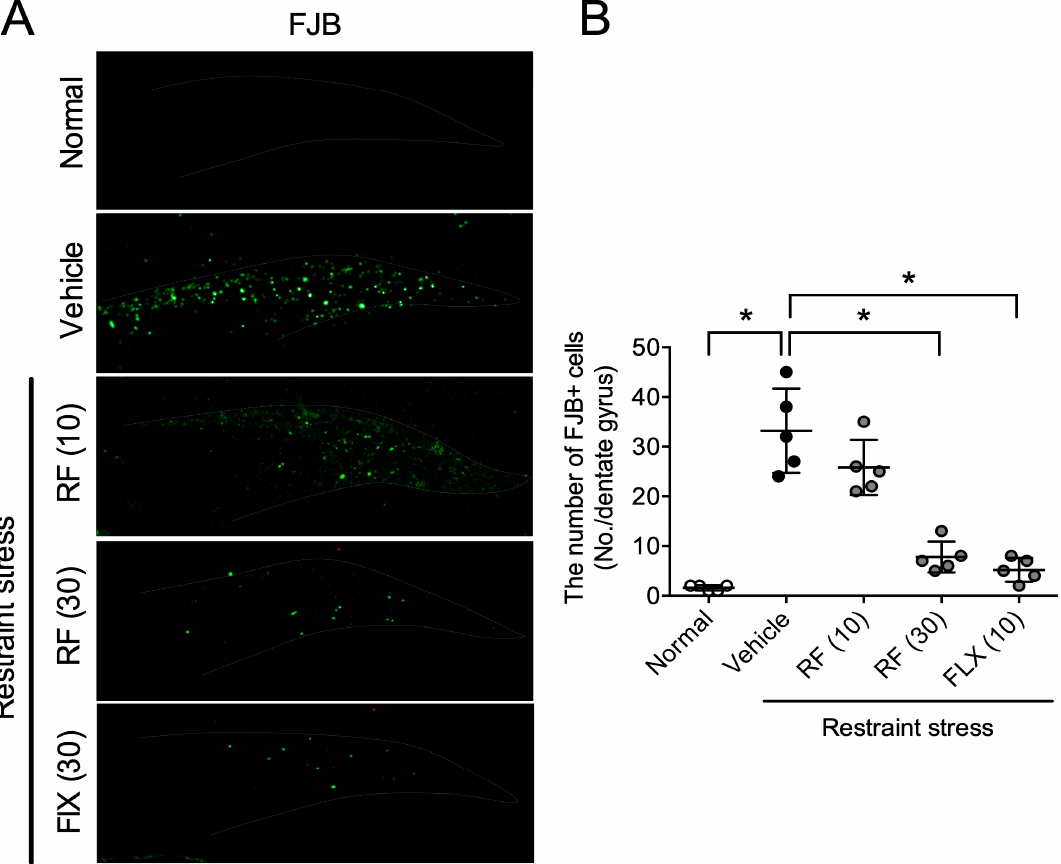
Figure 2. Effect of rubrofusarin on neurodegeneration: ( A ) Photomicroscopic image of Fluoro Jade-B (FJB)-positive cells in the dentate gyrus region. ( B ) Quantitative analysis of the number of FJB-positive cells in the dentate gyrus region. Data are represented as mean ± SD with raw data. * p < 0.05.